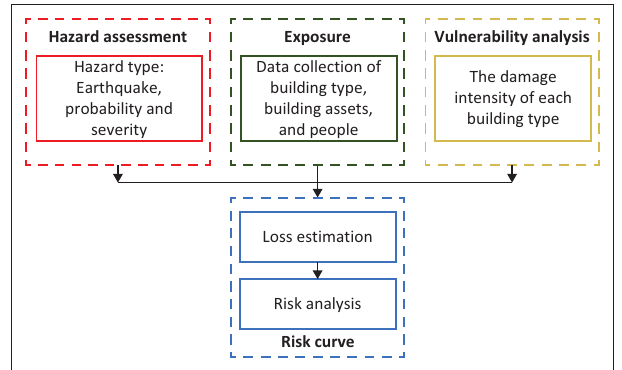
FIGURE 1: Risk assessment model: (a) normal condition and (b) after the risk reduction. FIGURE 2: Risk curve